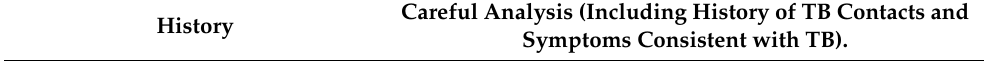
Table 2. Recommended pediatric TB diagnostic algorithm for children with tuberculosis in Uzbek- istan,